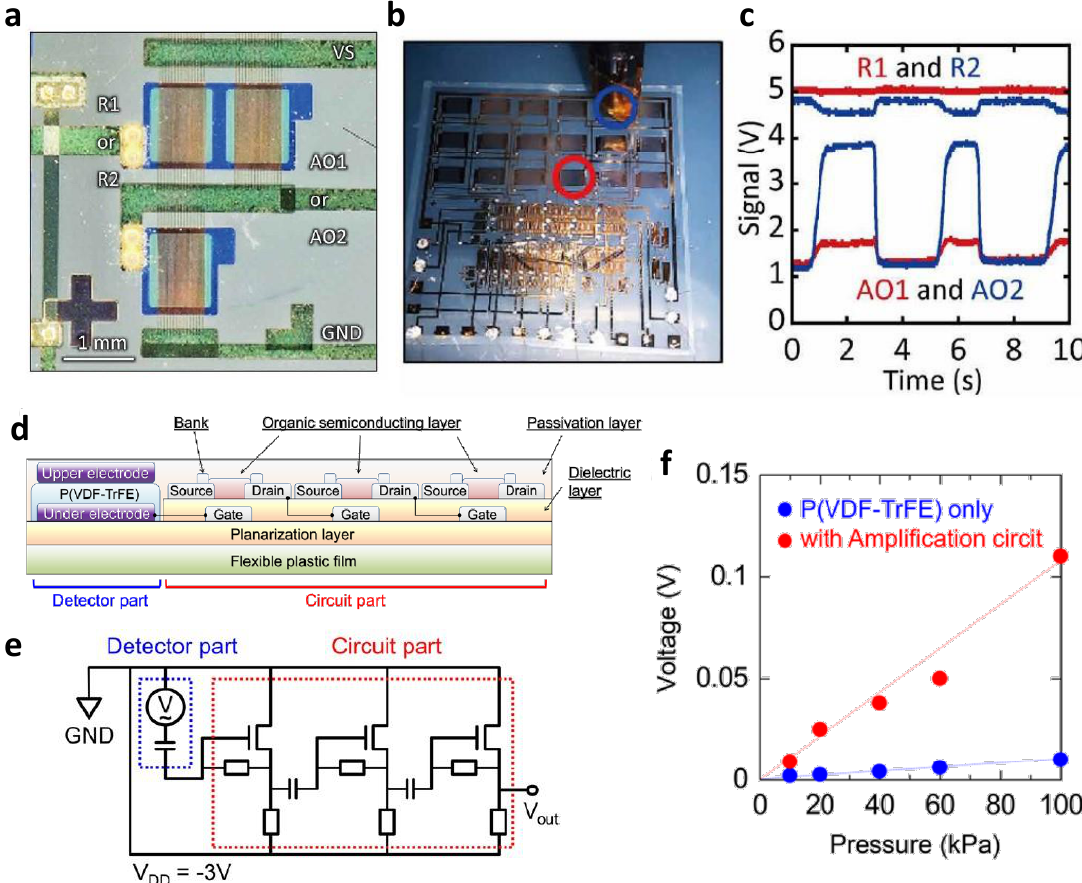
Figure 8. Organic-based thin-film analog circuits. ( a ) An optical microscope image of a common source amplifier, one of the elements constituting an organic-based active magnetosensory matrix system. ( b ) An image of a magnet approaching one of the GMR sensors away from each other and ( c ) the signal before and after amplification of the two GMR sensors at this time (adapted from [ 80 ] with permission from AAAS publications). ( d ) Structural schematic and ( e ) circuit diagram of a highly pressure-sensitive printed sensor consisting of a pressure-sensing part based on P(VDF-TrFE) and a circuit amplifying the sensed signal. ( f ) Comparison of the final generated voltage with and without the amplifier circuit when the same amount of pressure change is sensed in the P(VDF-TrFE) layer (adapted from [ 81 ] with permission from American Chemical Society).